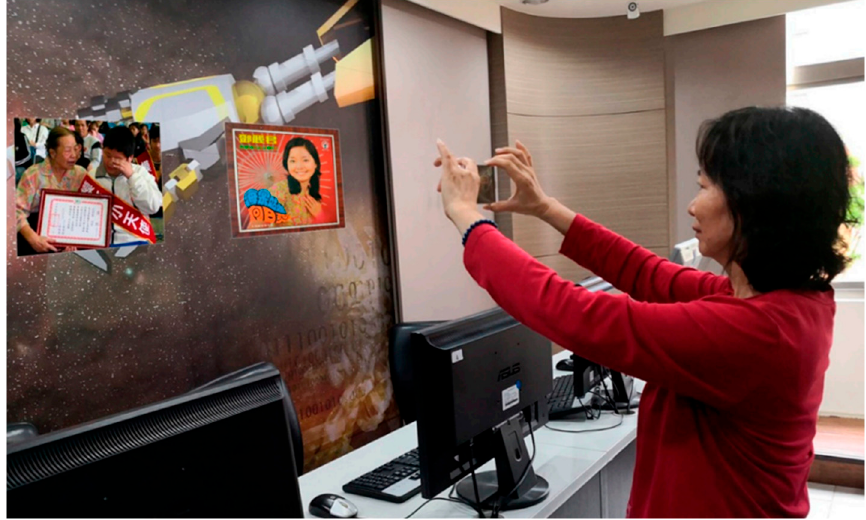
Figure 7. Demonstration of device screen mode (adapted from [69]).